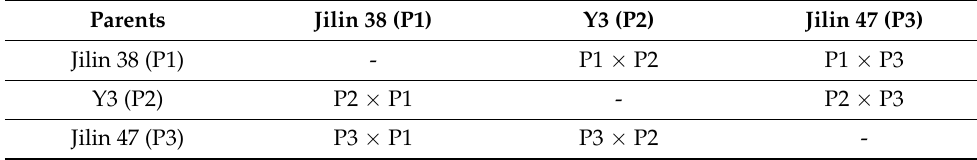
Table 1. Crosses between parents, Jilin 38/Y3/Jilin47 and respective F1